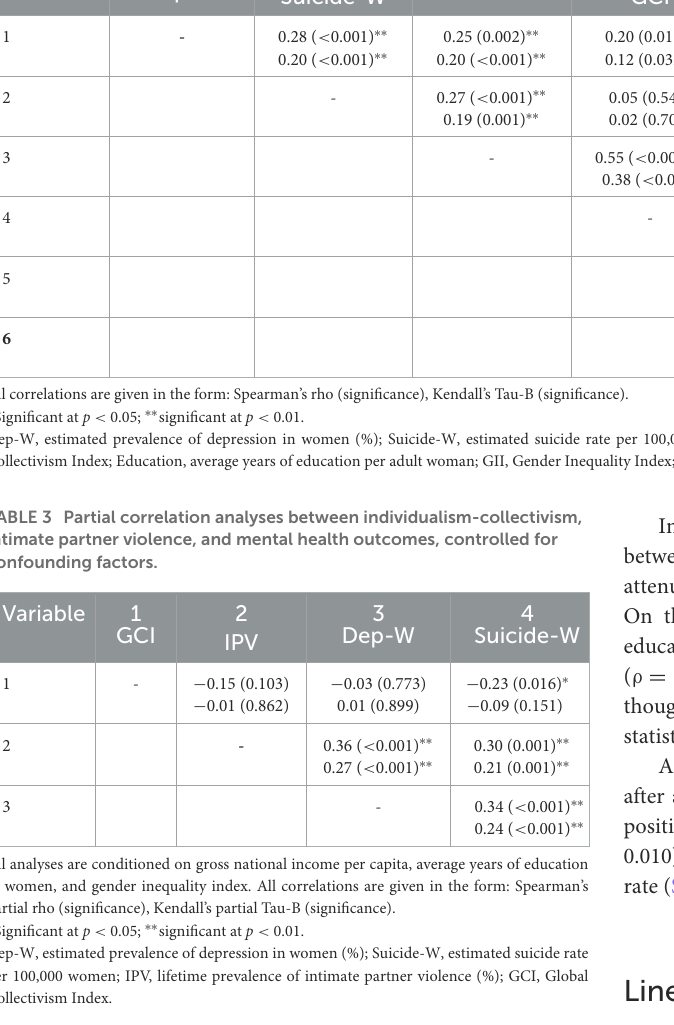
TABLE 2 Correlation matrix of unadjusted bivariate correlations between individualism-collectivism, intimate partner violence, mental health outcomes, and possible confounding factors. Variable